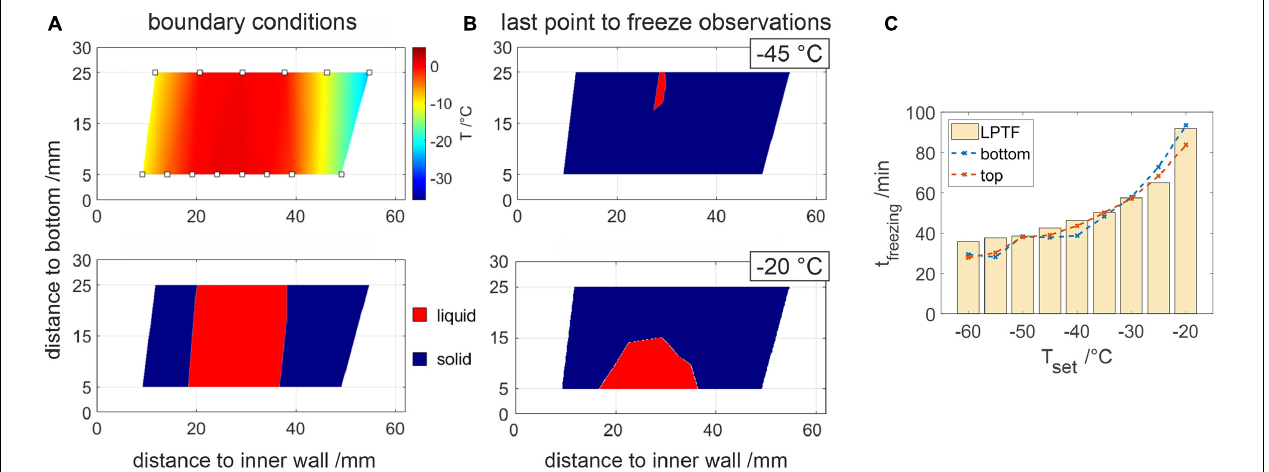
FIGURE 3 | 2D resolved temperature analysis of the chamber cross-section. (A) displays interpolated temperature data, where temperature probes are indicated by rectangles. In the lower figure, temperatures below –1 ◦ C and above are highlighted by blue and red, respectively. Panel (B) shows highlighted temperatures prior to the LPTF for –45 and –20 ◦ C. (C) Comparison of the individual freezing times at the bottom and top temperature sensor at different set temperatures. LPTF times determined by the temperature slope are plotted as bar plots for reference.